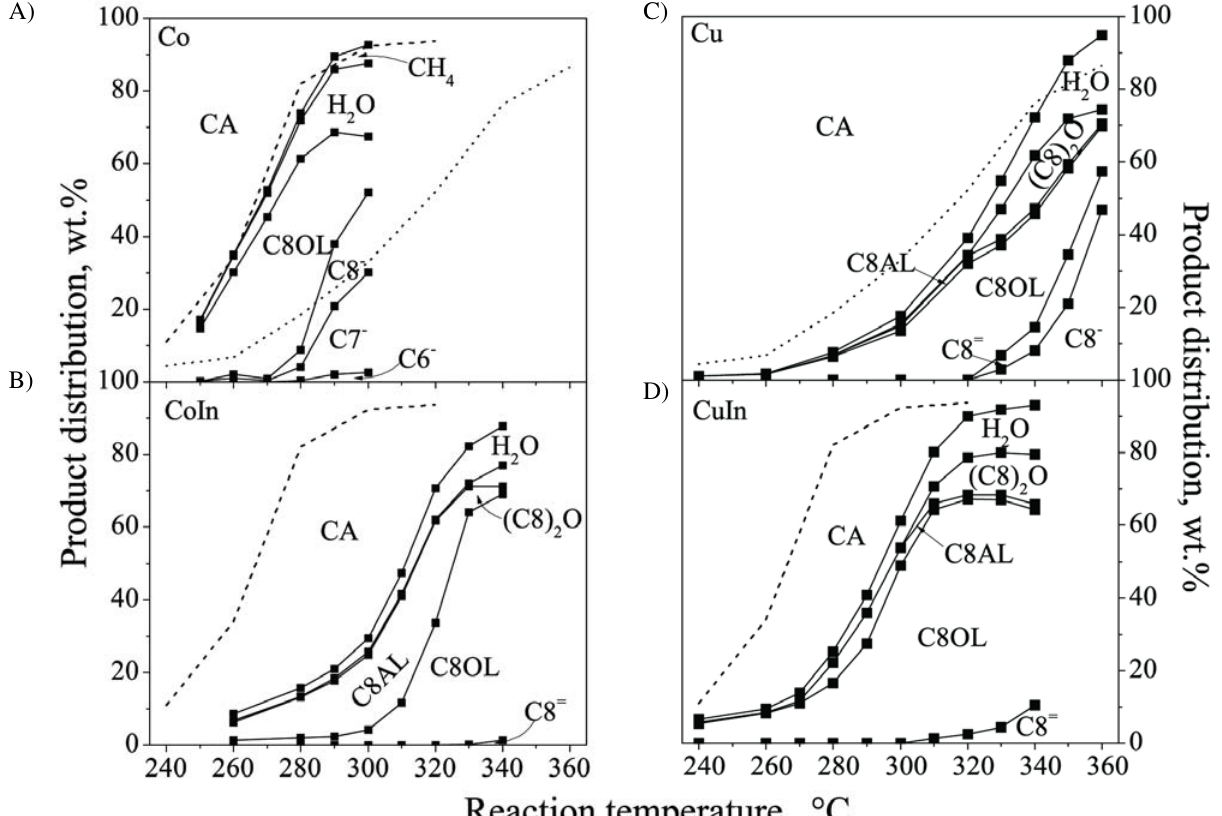
Fig. 3. Stacked area graphs of product distributions obtained from the hydroconversion of CA over catalysts (A) 9Co/Al [ 10 ] and (D) 9Cu/Al O /10% In O (C) 9Cu/Al O 9Co/Al 2 3 2 3 2 3 the WHSV of OA was 2 h –1 . Dashed lines are the conversion curves of 9Ni/Al bols as in Fig. 2.).